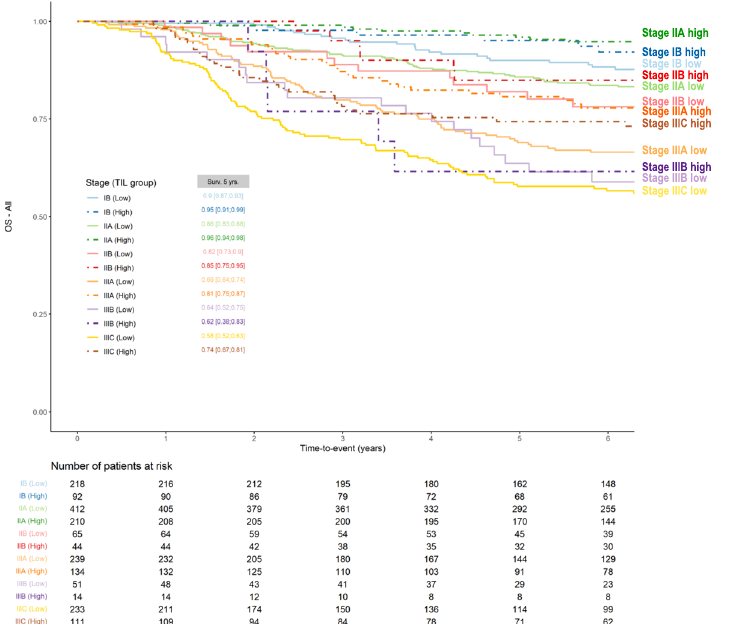
Fig. 1 Kaplan – Meier curves of overall survival of triple-negative breast cancer patients treated with anthracycline-based chemotherapy with or without taxanes, according to pathological prognostic stage and TILs. Pathological Prognostic Stage is assigned stage for patients who have surgical resection as the initial treatment of their cancer before receipt of any systemic or radiation therapy. It is based on clinical information, biomarker data, and fi ndings from surgery and resected tissue. The 5-year estimated overall survival values (5-Yr OS) are provided together with bootstrap con fi dence intervals.